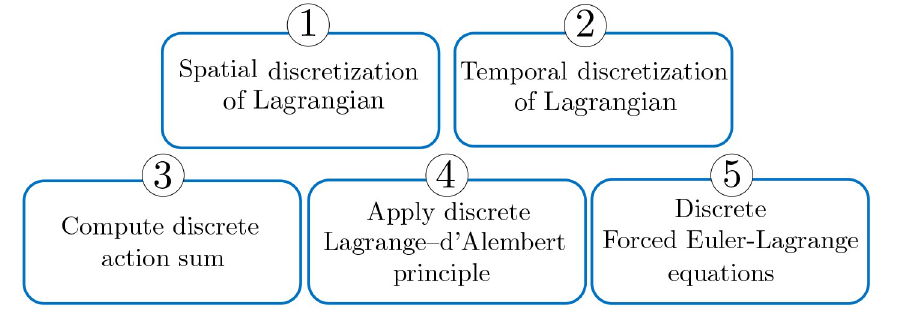
Fig 2. Steps 1 through 5 toward deriving continuum manipulator discrete